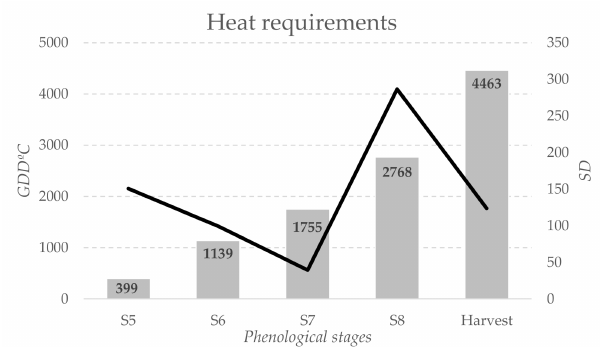
Figure 3. Heat requirements (GDD ◦ C)—average values for the different phenological (S5: Stage 5; S6: Stage 6; S7: Stage 7; S8: Stage 8), considering 1 ◦ C threshold temperatures (Th). In line with the standard deviation at each stage